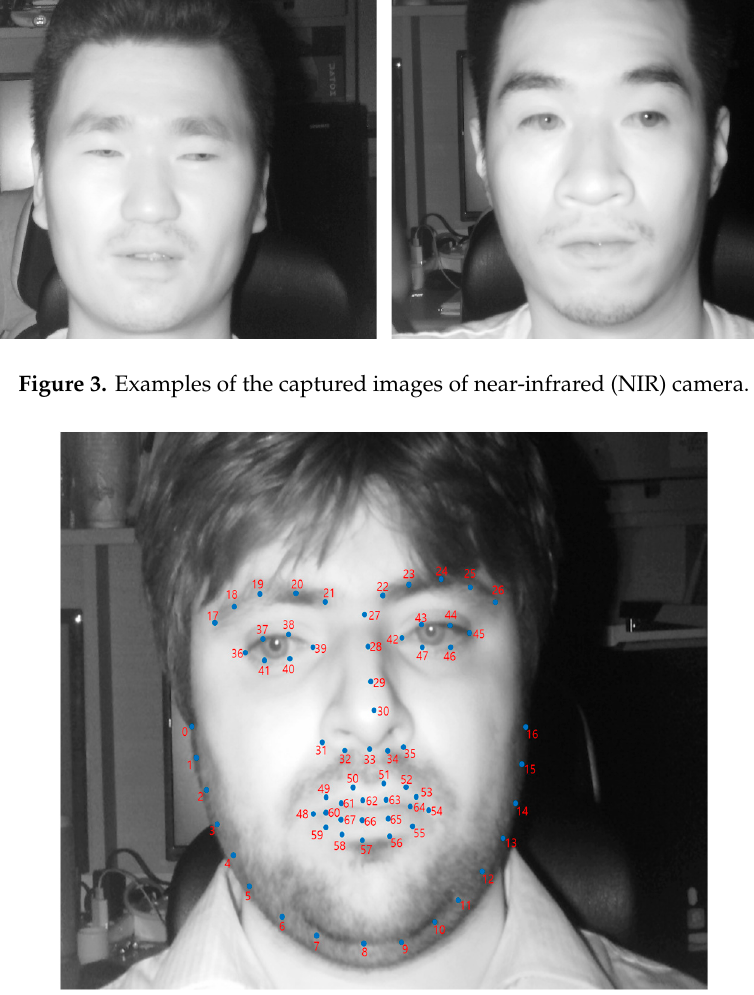
Figure 4 . Examples of detected facial feature points and their corresponding index numbers. Figure 4. Examples of detected facial feature points and their corresponding index